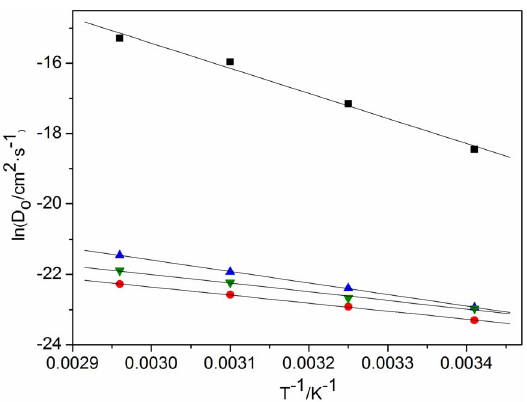
2 1 , & , Eu(III); N , Sm(III); m ,